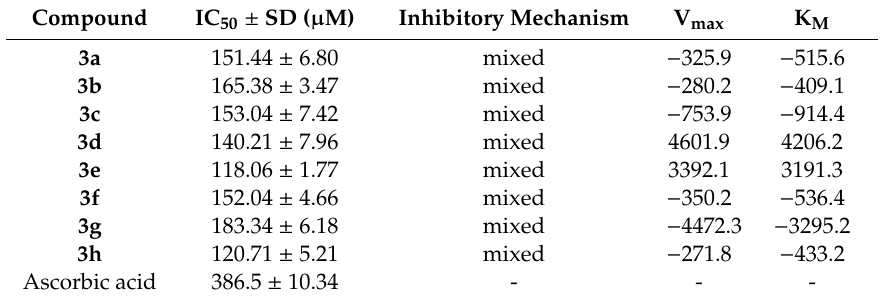
Table 3. Tyrosinase inhibitory activity of tropinone-thiazole derivatives 3a – 3h compared to standard inhibitor ascorbic acid. The mechanism of inhibition, maximum velocity (V max ), and inhibition constant (K M ) in the tyrosinase-catalyzed oxidation of L-DOPA. Compounds at concentration 100 µ M.